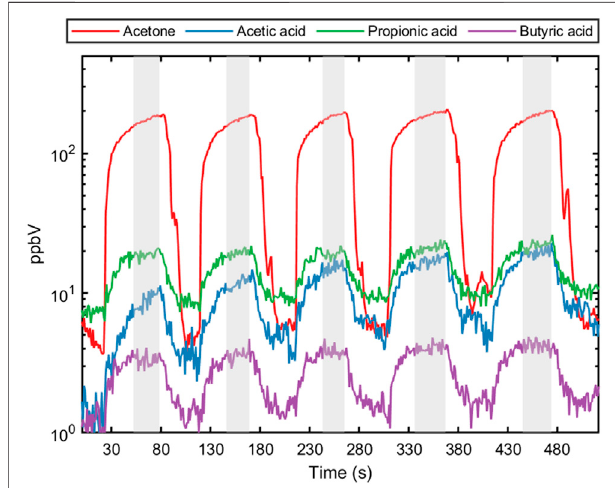
FIGURE 2 | Five consecutive exhalation pro fi les for acetone (breath marker)andeachshort-chainfattyacid(aceticacid,propionicacidandbutyric acid) from a healthy individual. The shaded area represents the end-tidal part of the exhaled breath used for calculating concentration and evaluating sample